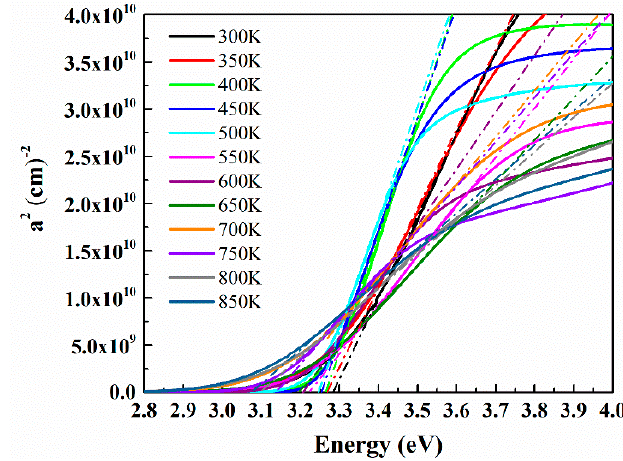
Figure 9. The square of the absorption coefficient ( α 2 ) vs. photon energy at different temperature for sample S 0 .